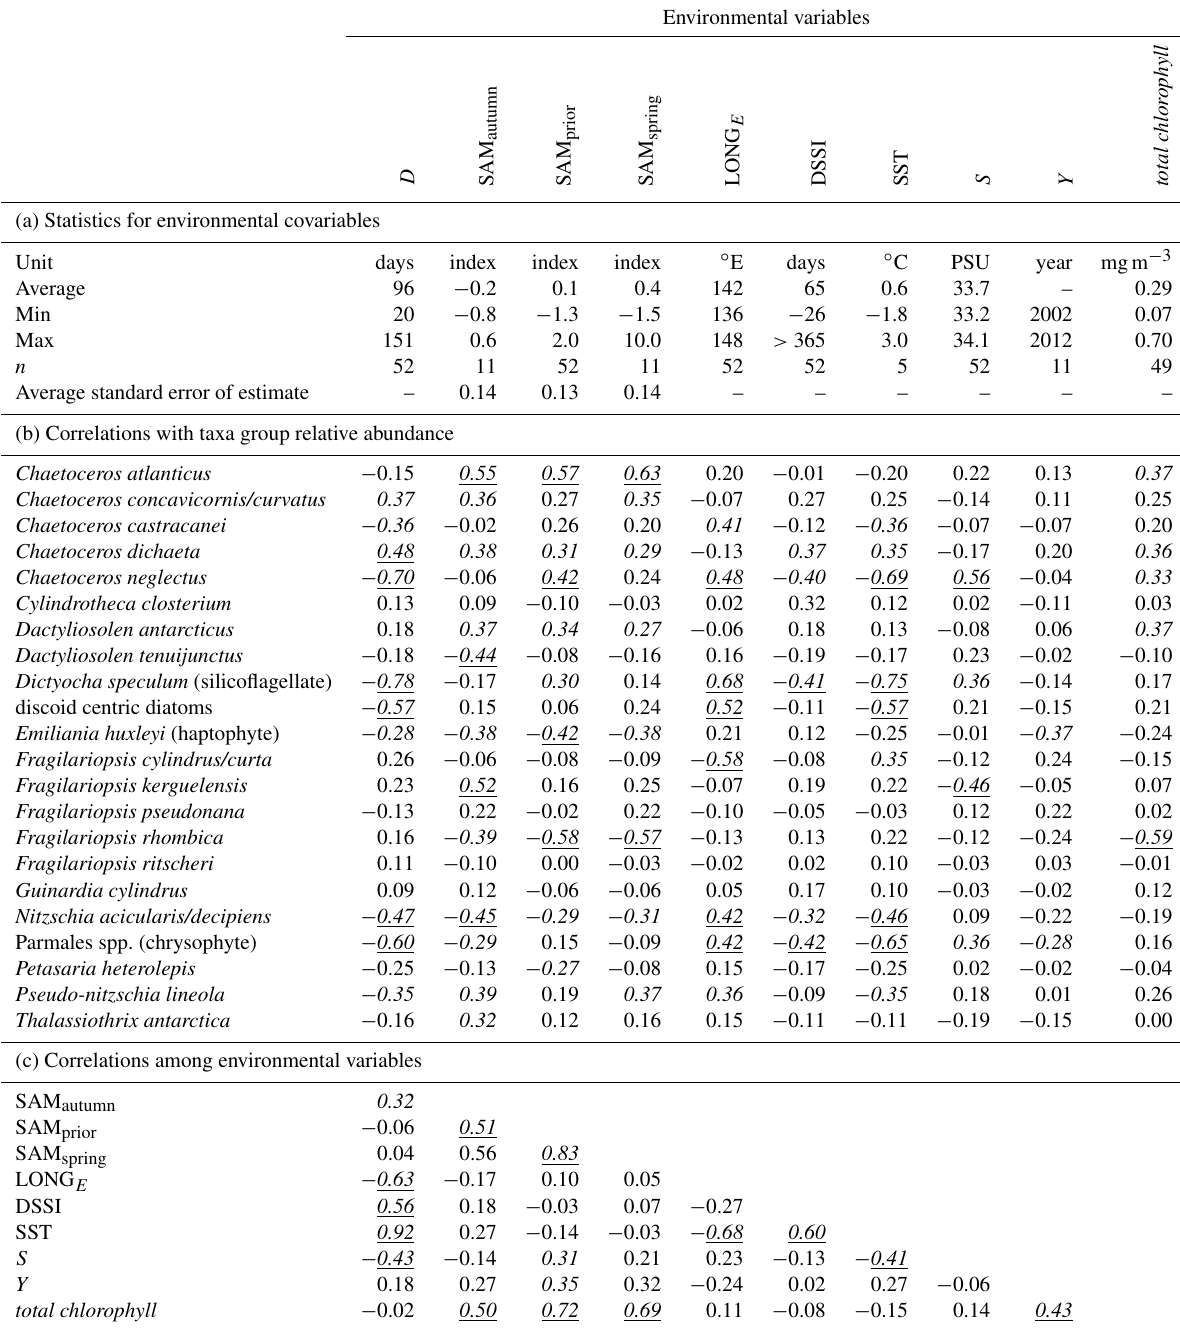
Table 2. (a) Summary statistics for environmental variables; (b) correlations between taxa group relative abundances and environmental vari- ables; (c) correlations among environmental variables; (d) correlations between macronutrient concentrations and environmental variables; (e) as in (f) but involving only the 50% of samples collected latest in the spring–summer. Correlations significant at α ≤ 0 . 05 are in italic, and correlations significant after Bonferroni adjustment are also underlined ( α < 0 . 05 / 19 for correlations among environmental variables, α < 0 . 05 / 20 for correlations with taxa group relative